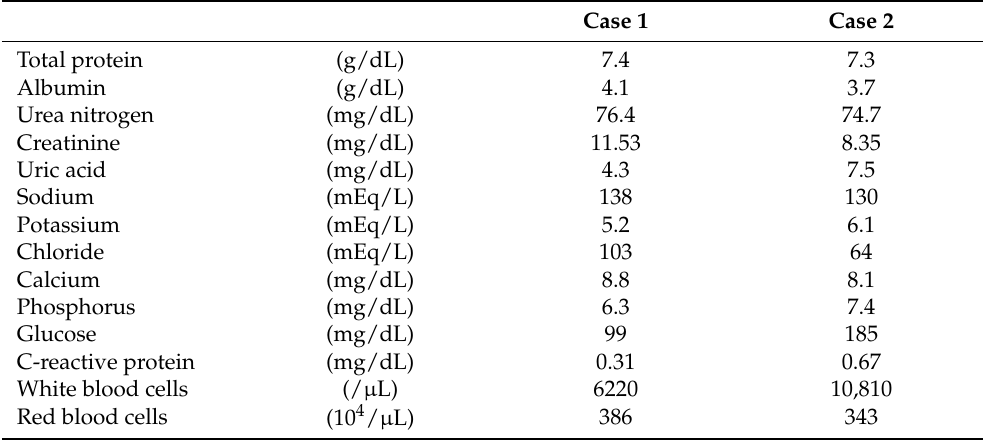
Table 1. Baseline